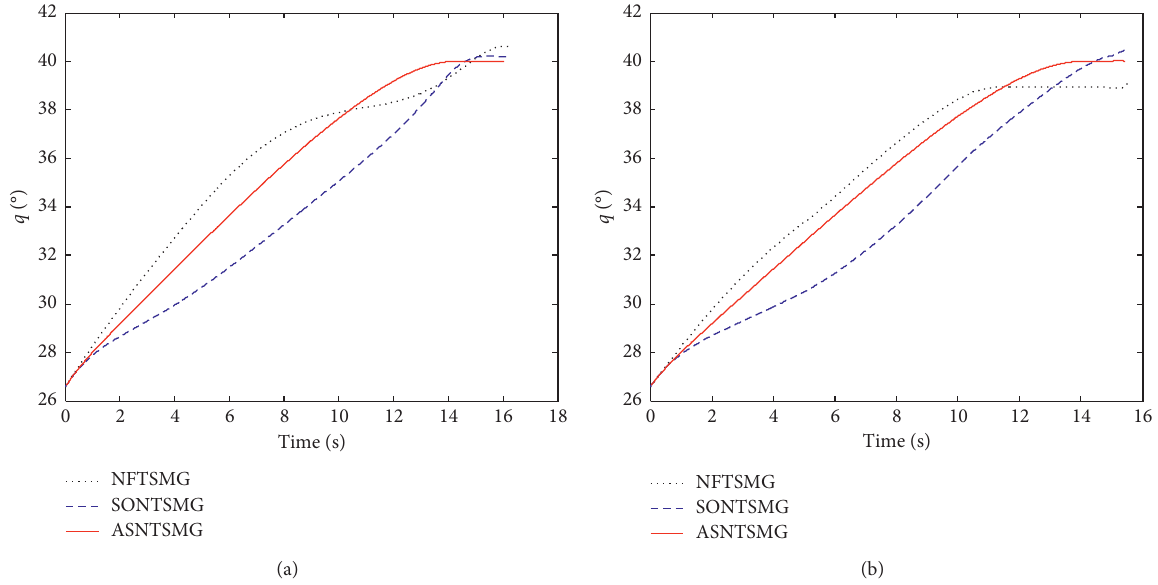
Figure 4: LOS angle. (a) Target cosine motion. (b) Target square wave